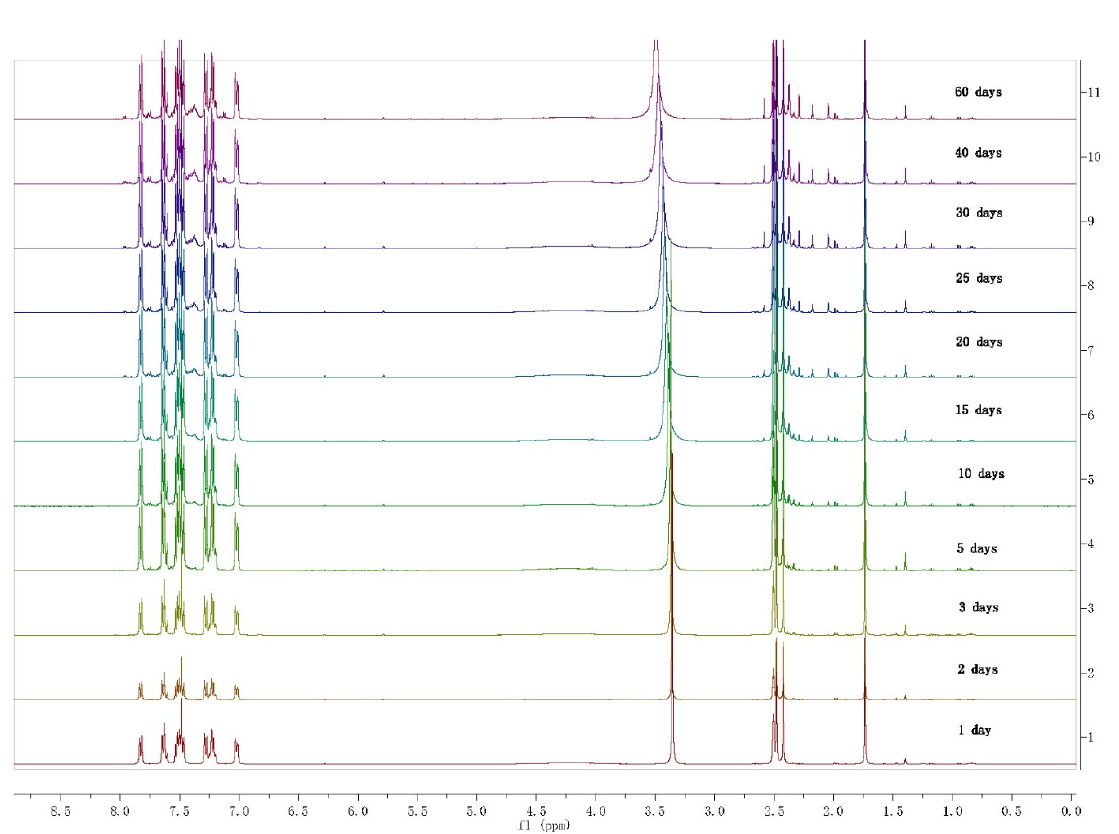
Figure 3. The stability of product 4a tested by a HNMR spectrometer.